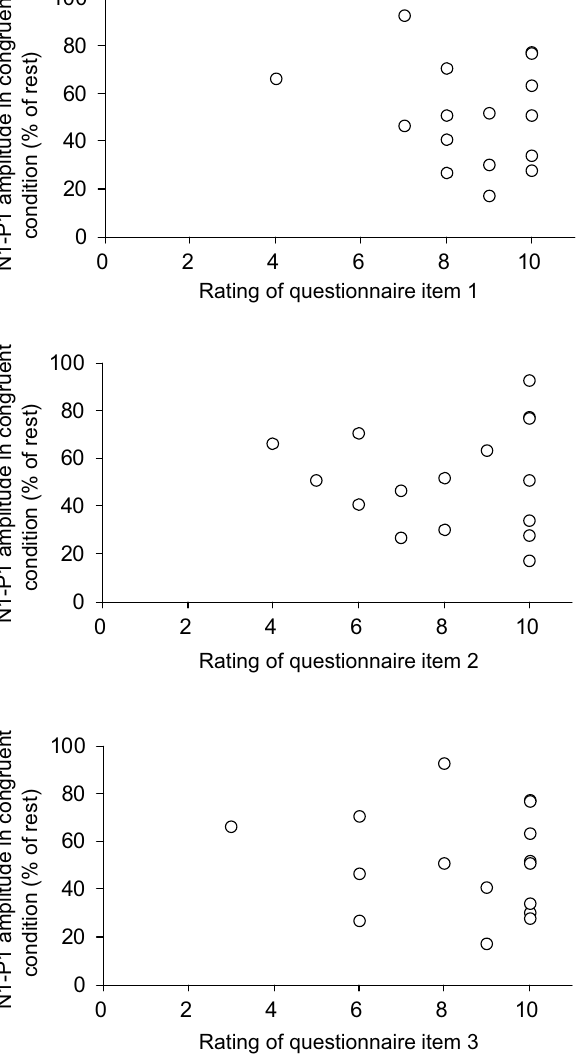
Figure 5. Correlation between the ratings of questionnaire items 1, 2, and 3 and the N1-P1 amplitudes in the congruent condition. Values on the ordinate indicate the N1-P1 sizes in the congruent condition as a percentage of those obtained from the